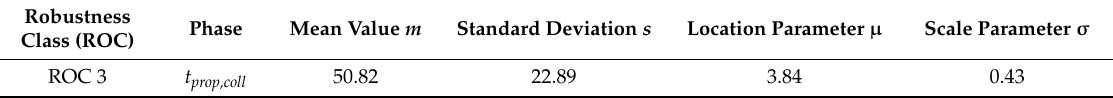
Table 18. Duration of propagation until the event of collapse t prop,coll .